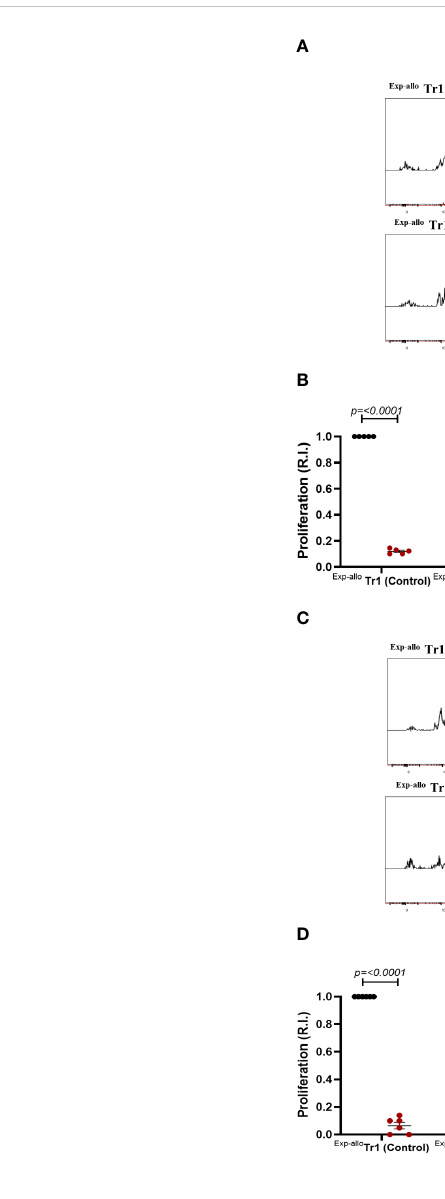
FIGURE 9 Exp-allo Tr1 cells maintain their suppressive capacity in presence of in fl ammatory cytokines. Co-culture of Exp-allo Tr1 and conventional CD3 + T cells were stimulated with allogeneic moDC in the presence or absence of in fl ammatory cytokines and T cell proliferation was evaluated. (A – D) Exp-allo Tr1 ef fi ciently suppressed the proliferation of both CD8 + (A, B) and CD4 + (C, D) R.T.C. in the presence of in fl ammatory cytokines IL-1 b , IL-6, IFN- g , TNF- a or all together (n= 5). All experiments were performed in duplicates. Data are representative of four independent experiments. The results are shown as mean ± SEM. Statistical analysis was performed using the unpaired-t test or one sample t and Wilcoxon